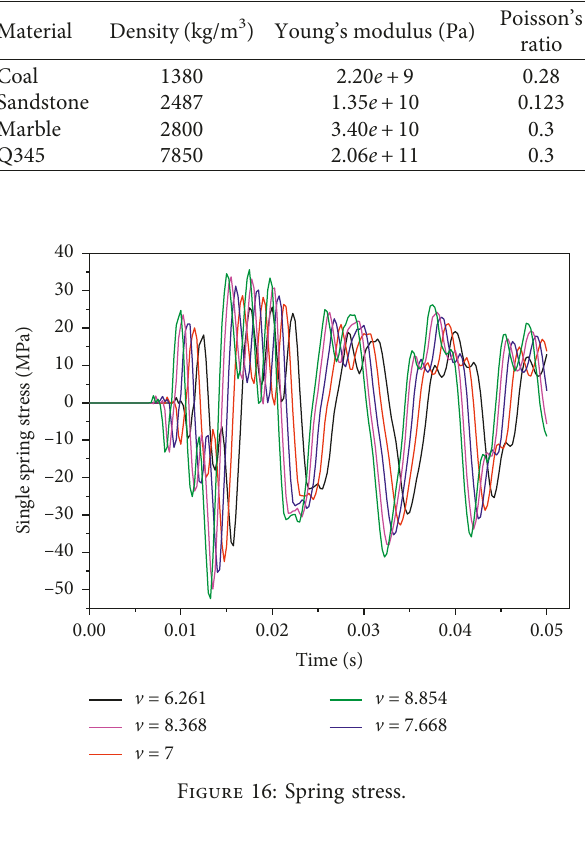
Figure 16: Spring stress.